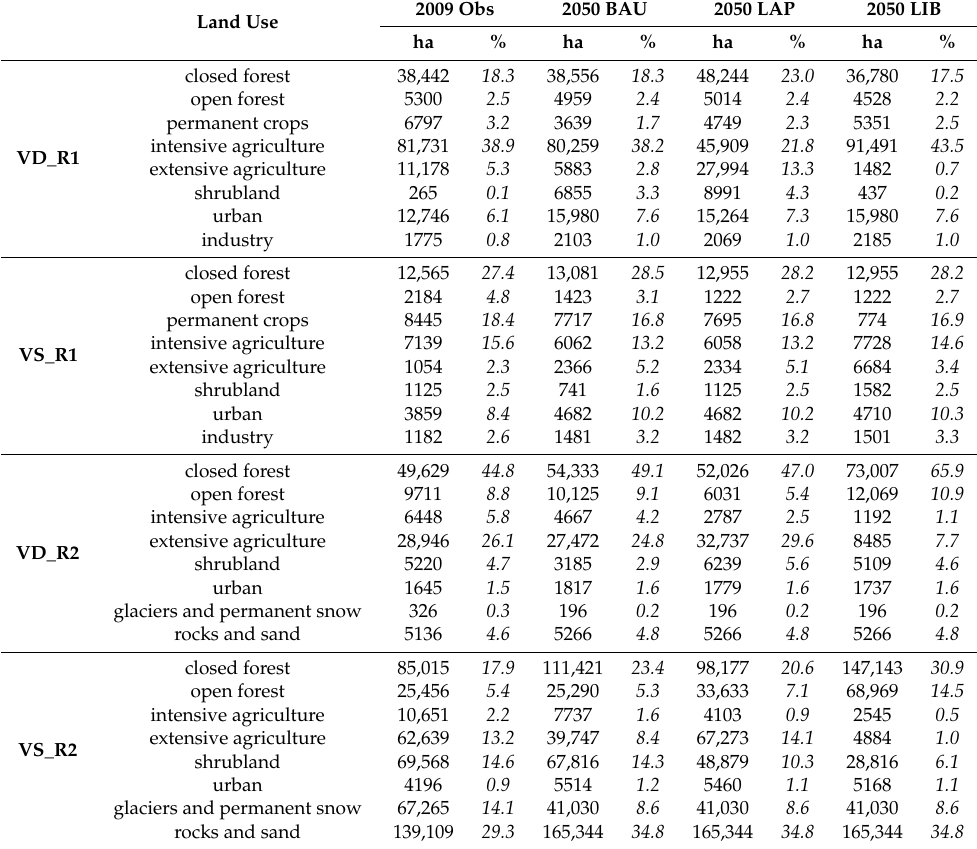
Table 7. Total area (ha and %) each LU class occupies in the observed 2009 dataset and in each scenario in 2050. The percentage of total area (%) was calculated with the area occupied by each region: 210,150 ha, 45,874 ha, 110,705 ha and 475,495 ha,